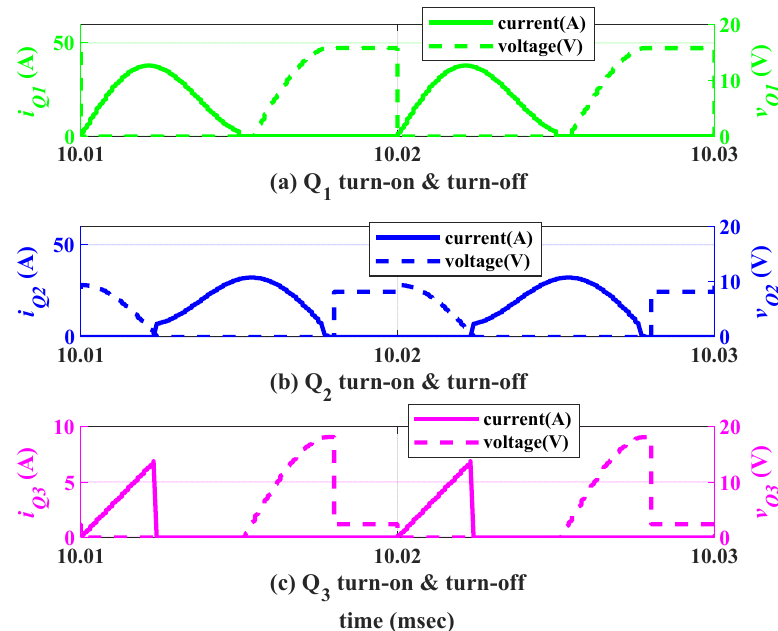
Figure 7. Soft-switching operation of the converter switches in